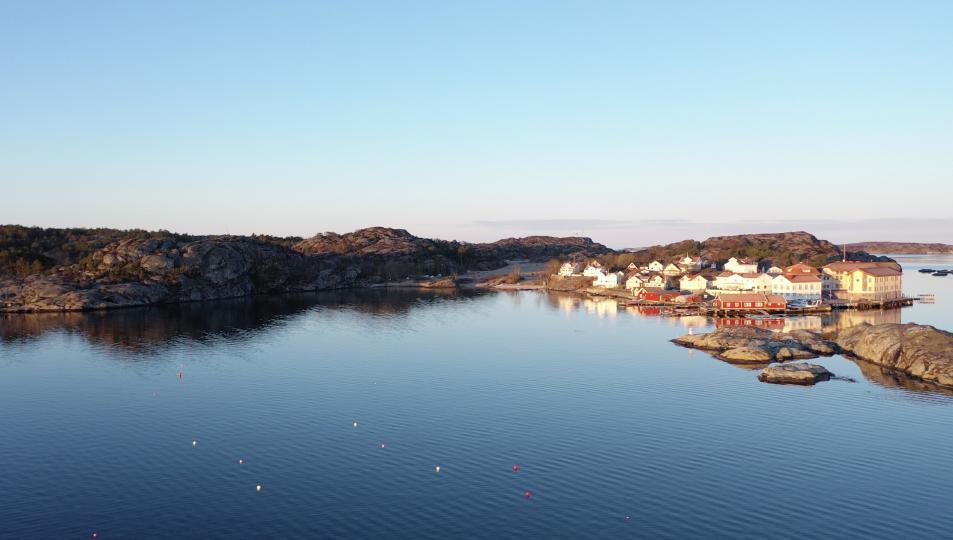
Figure 6. The test site (white buoys in the water) at the Kristineberg marine field station. This is the same site as modeled in the simulator described in this paper (photo: I.